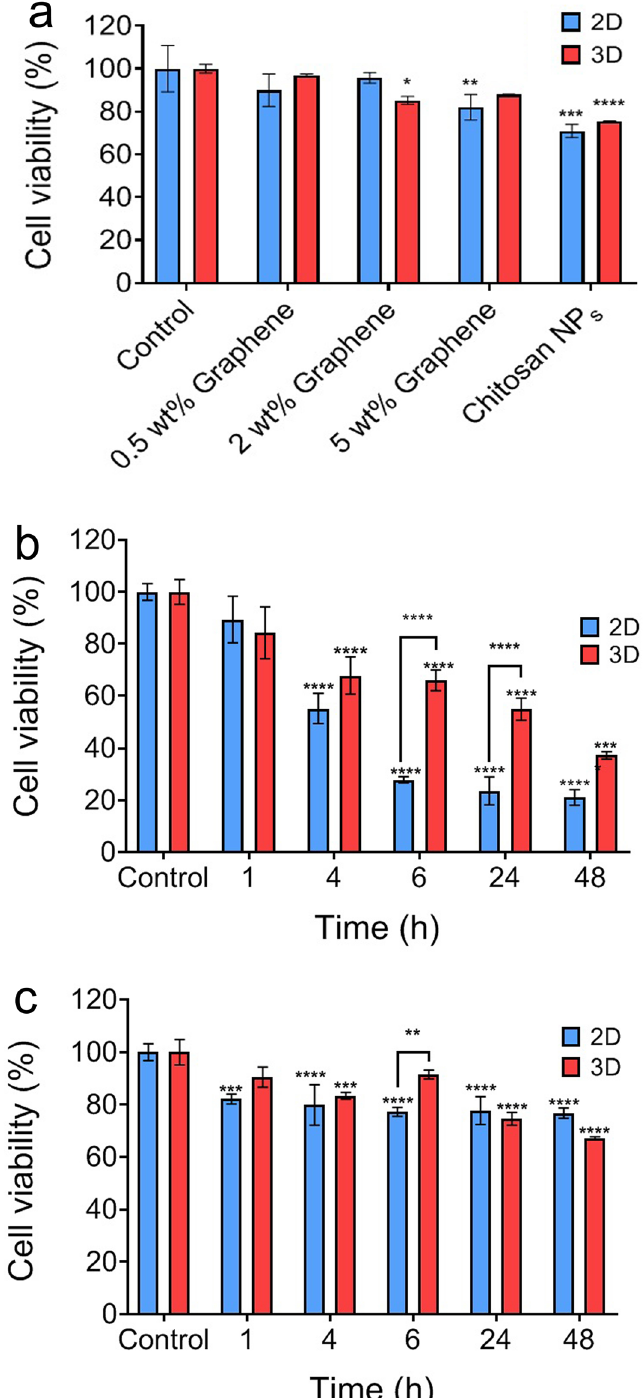
Figure 6. ( a ) Cytotoxicity of drug-free graphene/chitosan nanocomposites with 0.5, 2, and 5wt% of graphene and drug-free chitosan nanoparticles on SKBR-3 cell line in 2D and 3D cultures models using MTT assay, ( b ) cell viability of SKBR-3 cancer cells with DOX released after treatment with the graphene/chitosan nanocomposite with 2wt% of graphene in 2D and 3D cultures at pH 4.5 and ( c ) cell viability of SKBR-3 cancer cells with DOX released after treatment with the graphene/chitosan nanocomposite with 2wt% of graphene in 2D and 3D cultures at pH 7.4. Values are mean ± SEM (n = 3). Significant difference (P < 0.05) was marked with * (p < 0.0001: ****, p < 0.001: ***, p < 0.01: **, p < 0.05: